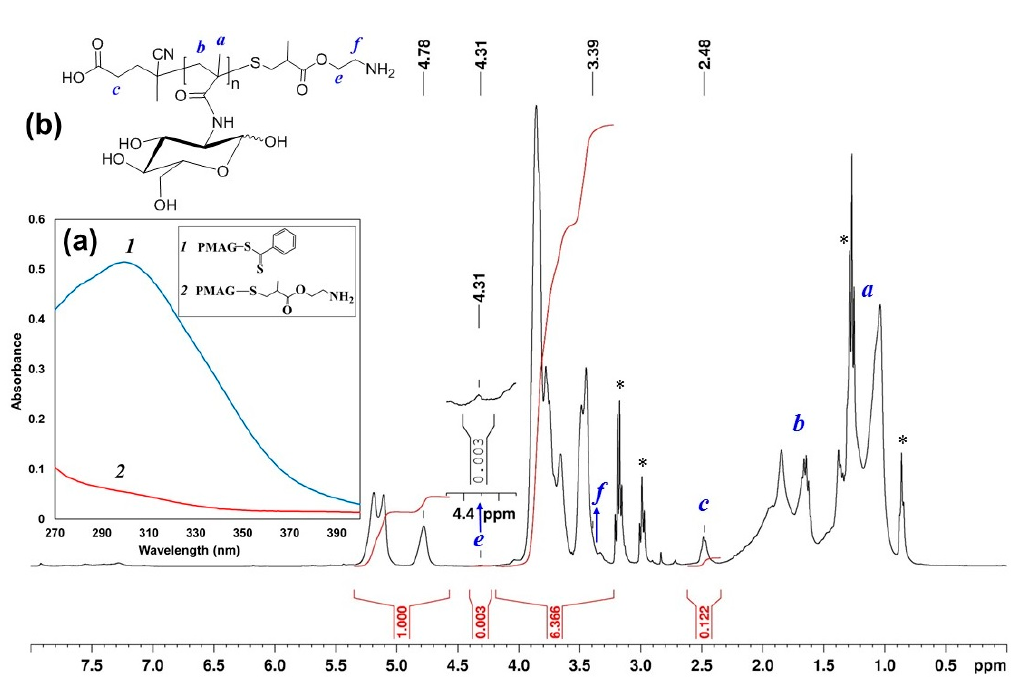
Figure 3. ( a ) UV spectrum of PMAG-CTA (1) and PMAG-NH 2 obtained from modification by AEMA ( 2 ) in DMF; ( b ) 1 H NMR spectrum of PMAG-NH 2 (* low-molecular by-products Et 3 N and HexA).